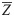
Comparison of facility for paired eyes using ‘Paired Facility plots’.Each data point represents one individual, with the log-transformed facility of each eye defining the co-ordinates. Filled ellipses indicate 95% confidence intervals from the regression fitting of Eq 9 (1.96sreg) and outer ellipses indicate additional uncertainty due to intra-individual variability (scon). Inset: facility in nl/min/mmHg. Unity line is shown in blue. Red line shows average difference Z¯, with its confidence intervals in grey. (a) Untreated contralateral pairs. No pairs exhibited a significant difference between contralateral eyes when accounting for uncertainty. (b) Effect of PDA205 treatment compared to control eyes. A significant increase in the facility following treatment is observed, although there is considerable variability (stre2) introduced by the drug.